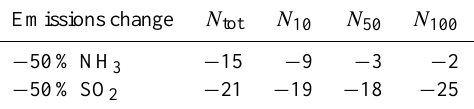
Table 3. Predicted impact (%) of halving SO 2 and NH 3 emissions in particle number concentrations in Europe during May